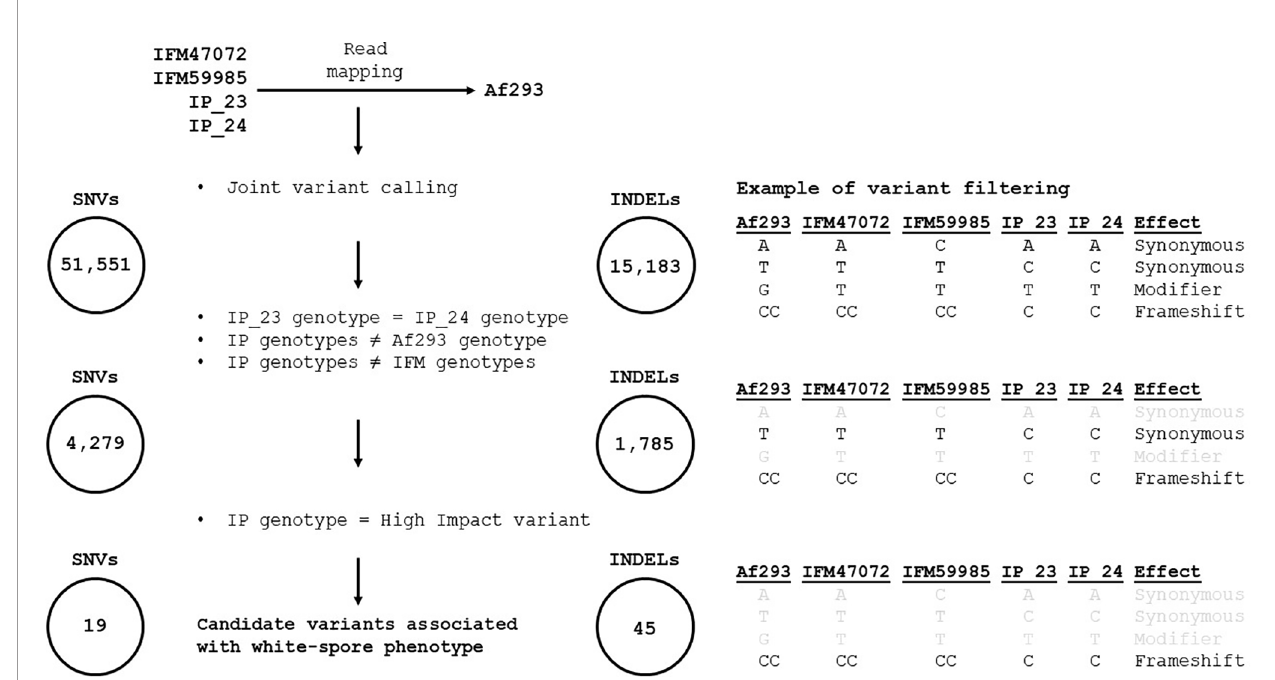
FIGURE 2 | Methodological pipeline to identify candidate variants associated with white-spore phenotype. Reads from IP_23, IP_24, IFM4702 and IFM59985 were independently mapped against the Af293 reference genome and joint genotyping was performed with FreeBayes, resulting in 51,551 SNVs and 15,183 indels. Variants were retained if (i) the variant was identical in IP_23 and IP_24, (ii) the IP_23 and IP_24 variant was different from the Af293 genotype, and (iii) the IP_23 and IP_24 variant was different from the IFM4702 and IFM59985 genotypes (resulting in 4,279 SNVs and 1,785 indels). Lastly, variants were retained if they were annotated as “ high impact ” by SnpEff. This process resulted in 19 and 45 candidate SNVs and indels, respectively. The right panel provides an example of our fi ltering scheme. Gray text signi fi es variants that did not pass the fi ltering